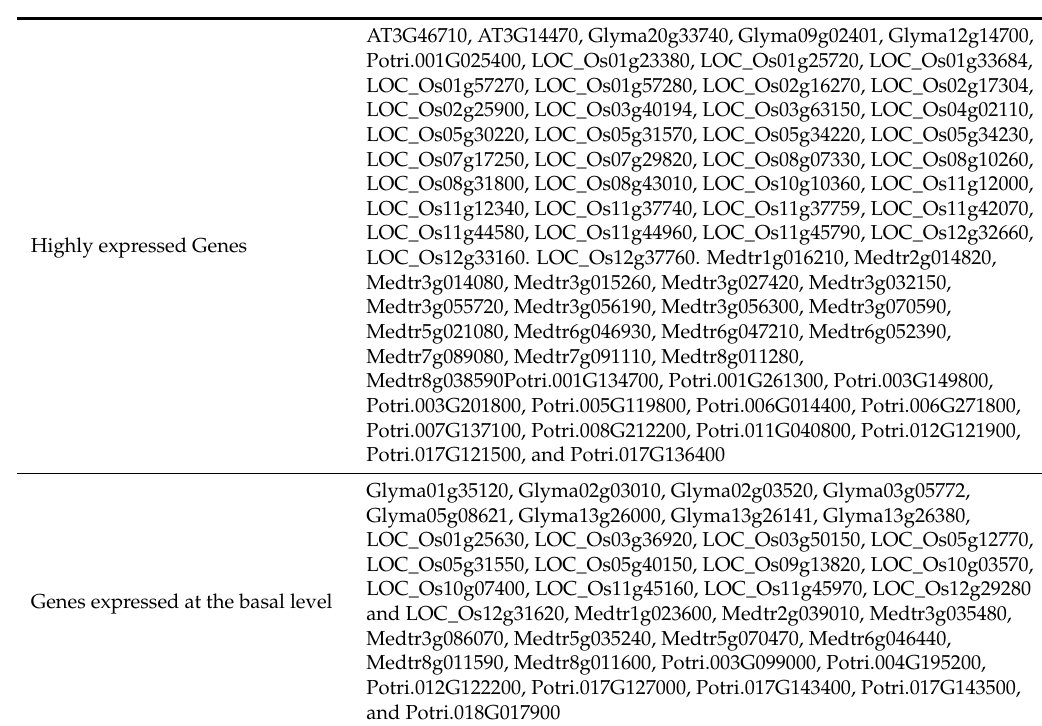
Table 6. CNL-C genes from the genomes of five different species showed differential gene expression (see Figures S20–S24 for more